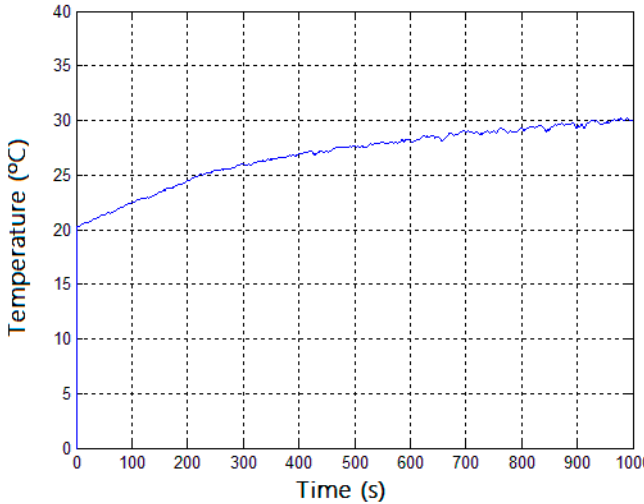
Figure 13. Temperature values, inside the motor, received and plotted on the computer.